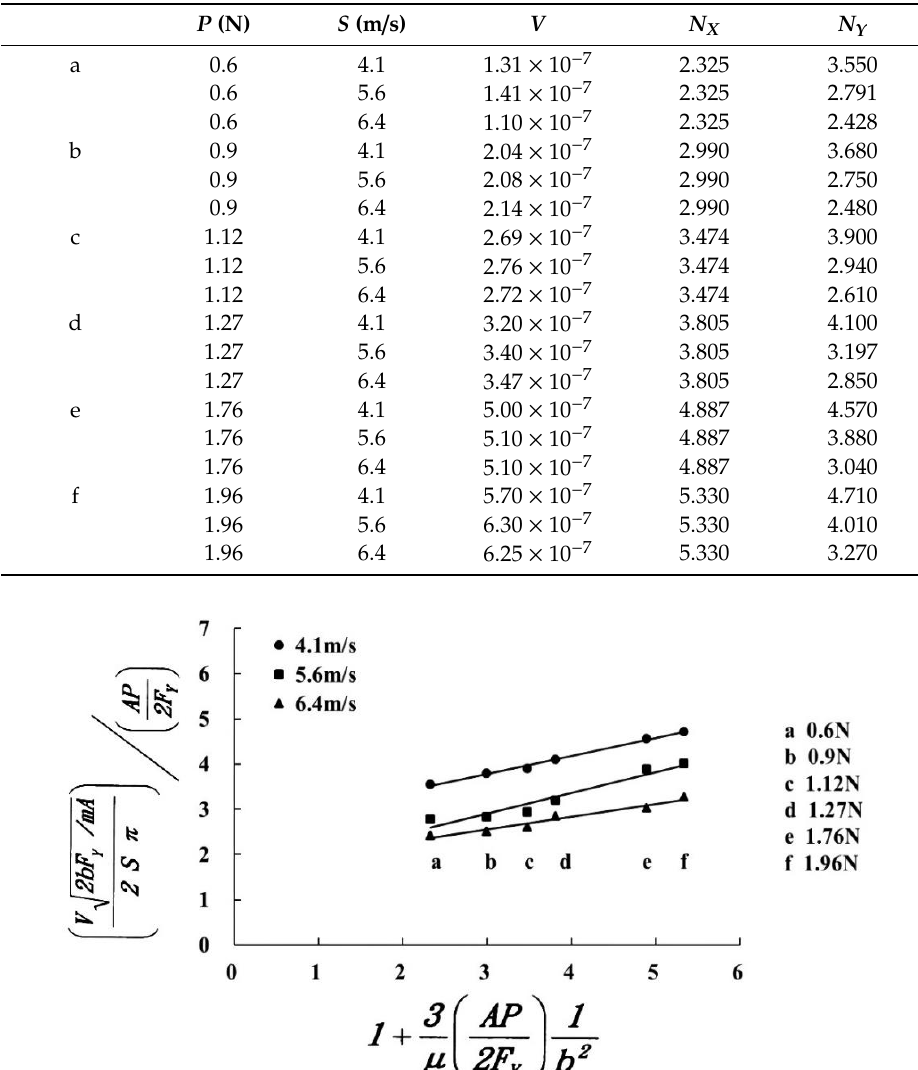
Table 2. Experimental conditions and results.